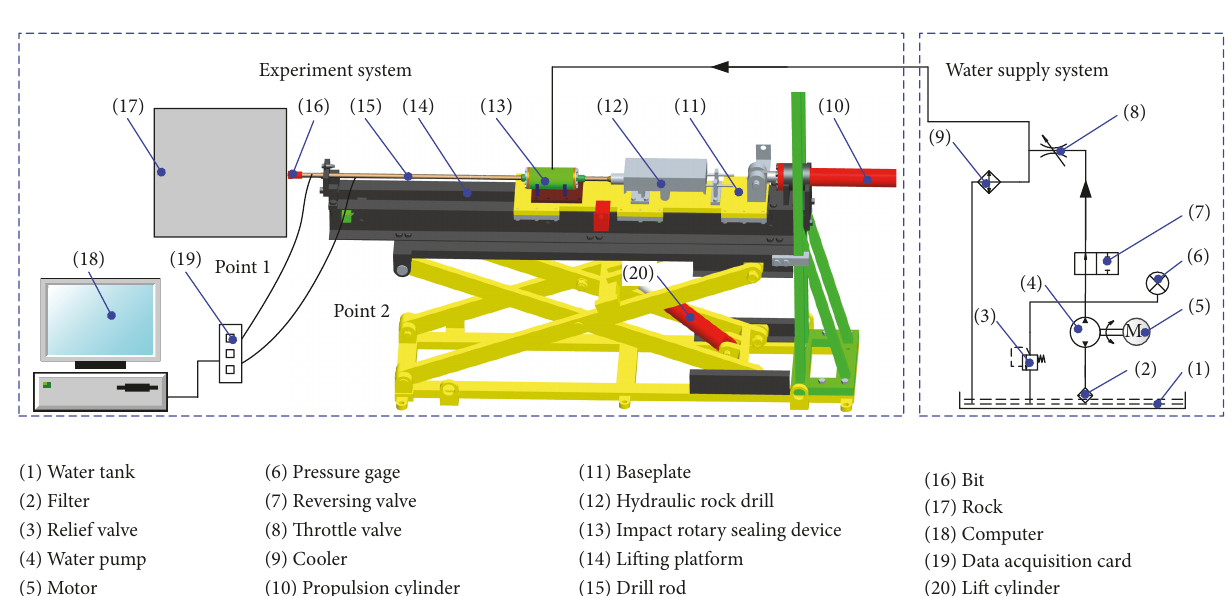
Figure 8: Test device of drilling assisted with water